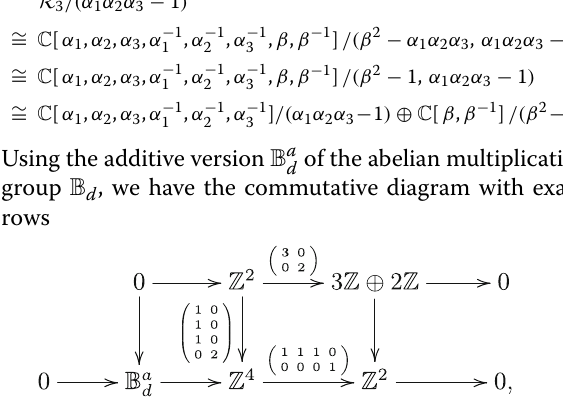
b corresponds to the center point of the cube generated by a 1 , a 2 and a 3